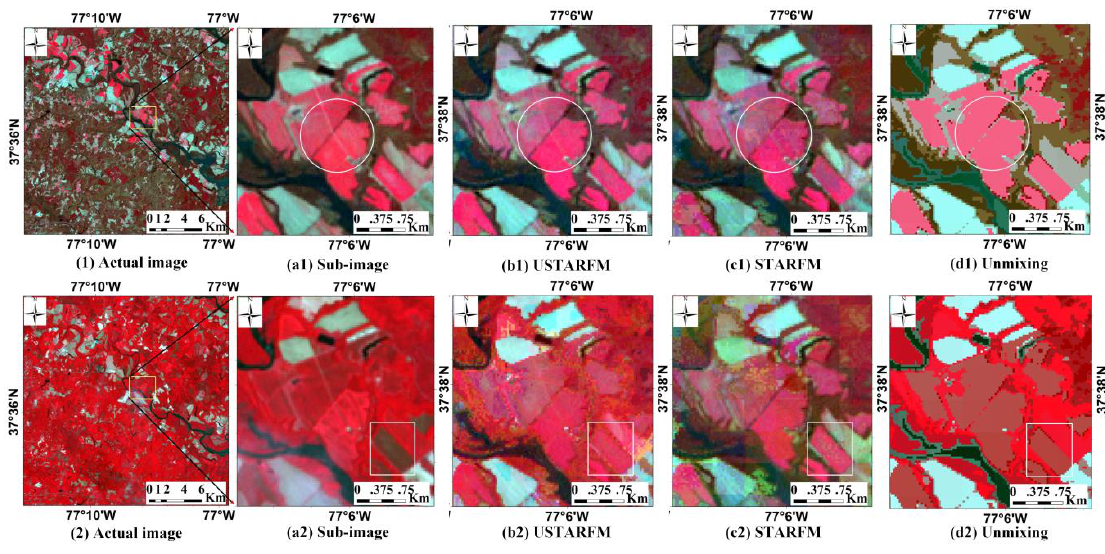
Figure 8. Landsat images collected 26 February 2002 (1) and May 17 (2) and their enlarged sub-images ( a1 ) and ( a2 ); and the corresponding prediction sub-images by USTARFM ( b1, b2 ), STARFM ( c1, c2 ), and unmixing-based method ( d1, d2 ).